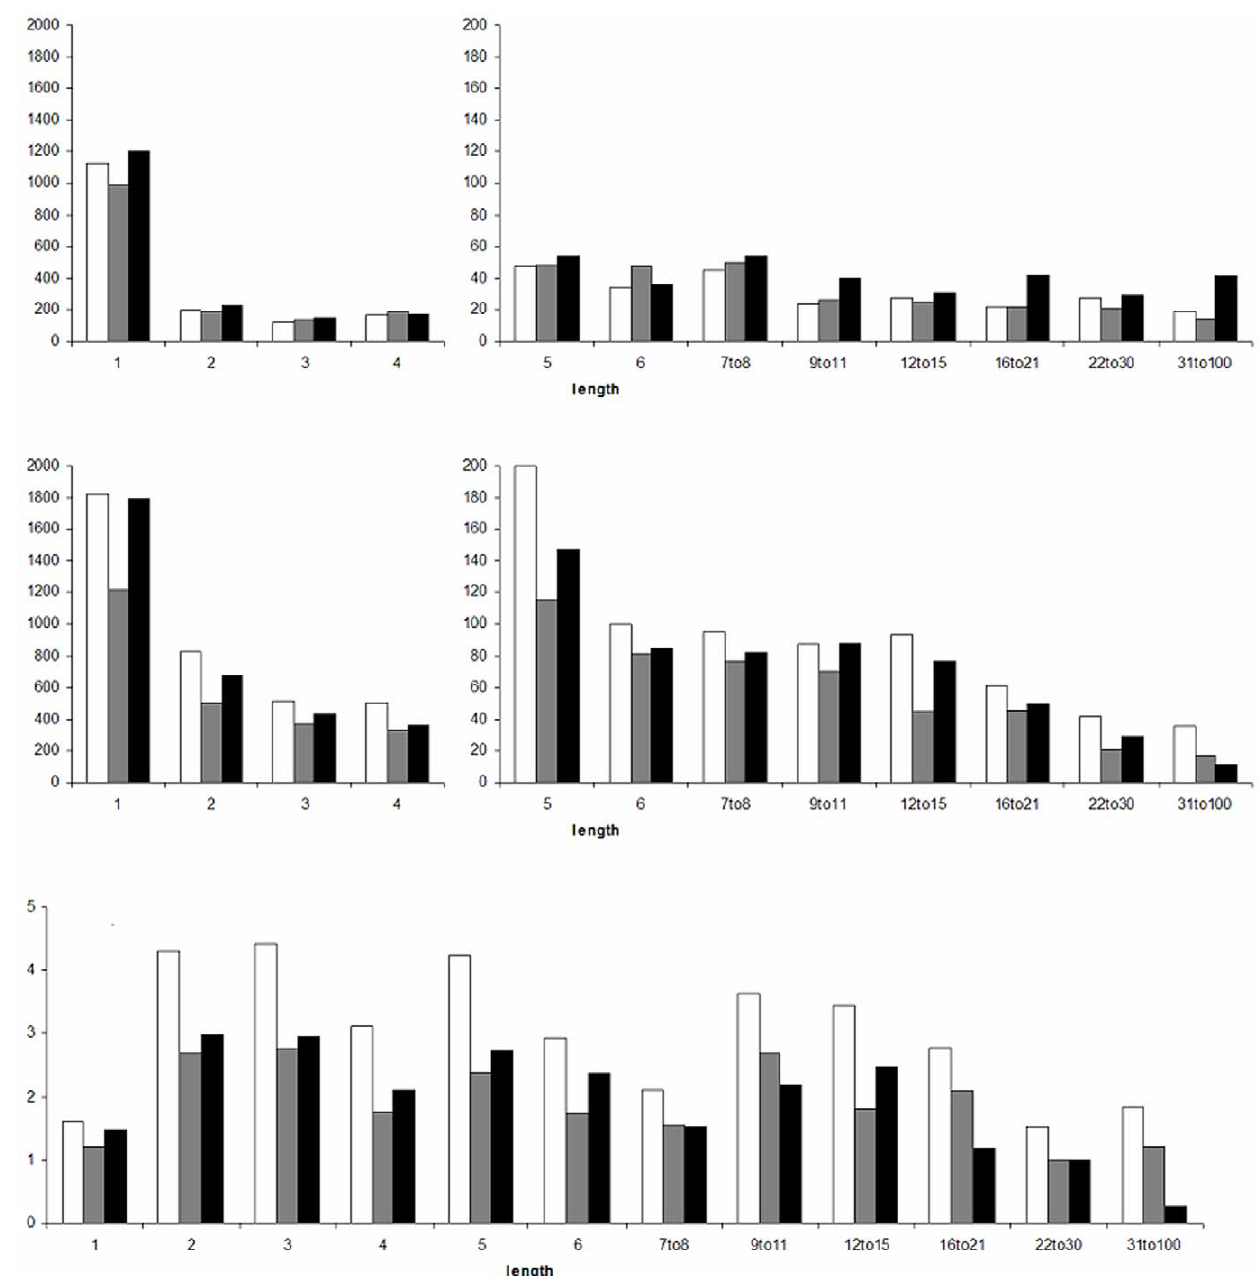
Figure 3. Indel counts. Deletion count (top), insertion count (middle) and DI-ratio (bottom) for different indel lengths (in bp) (white: polymorphic human, grey: fixed human, black: chimp). Note the difference in scale on the y-axis for indels of length 1 to 4 bp and those longer in the two top graphs. Length classes constructed such that the smallest count in any of the six possible indel categories was larger than 20 (except for indels of length 31 to 100 bp for which only the count of polymorphic human deletions and chimp insertions were larger than